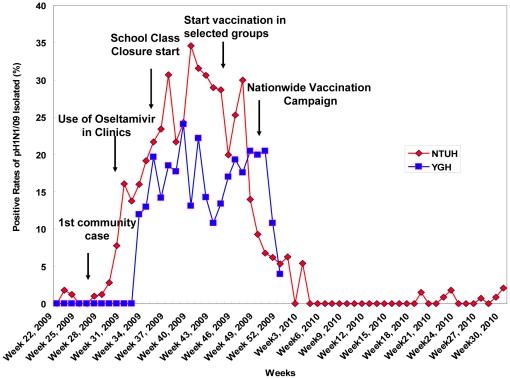
Weekly distributions of positive rates of pH1N1 isolated from NTUH and YGH in Taiwan, 2009–2010.NTUH: National Taiwan University Hospital located in Taipei; YGH: Yuan's General Hospital (YGH) located in Kaohsiung. The time frames of different public health prevention/control measures was indicated with arrows.